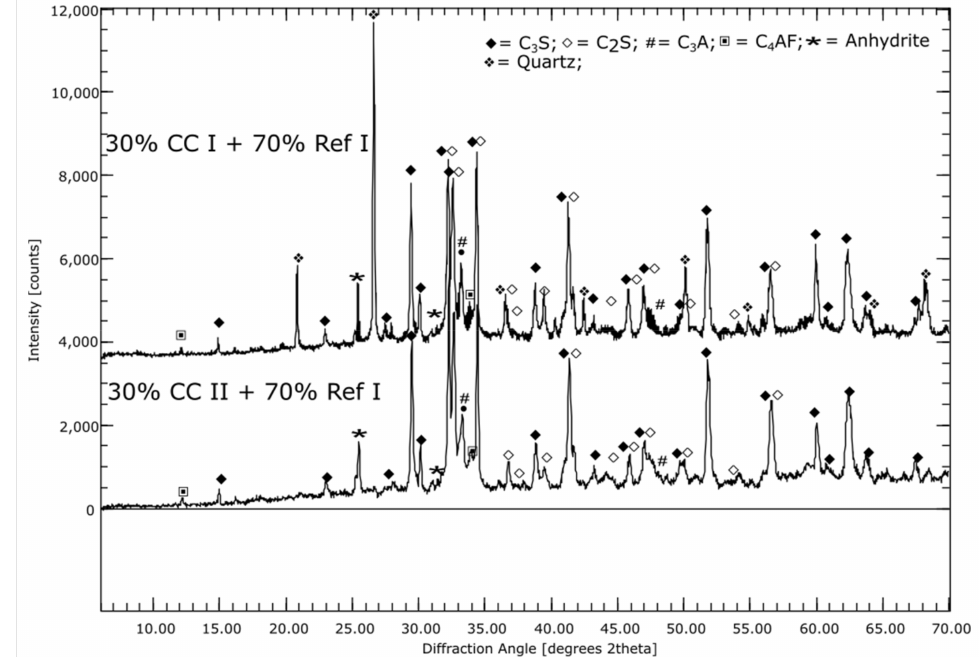
Figure A2. Graphical representation of XRD measurements: CC I and CC